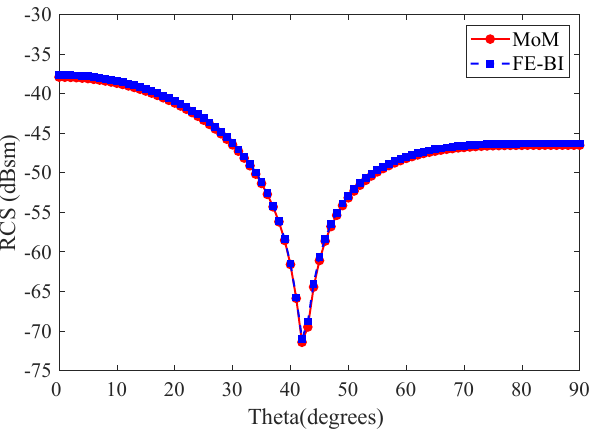
× . Figure 4. The monostatic RCS of a panel with size of 62 mm × 54 mm × 10